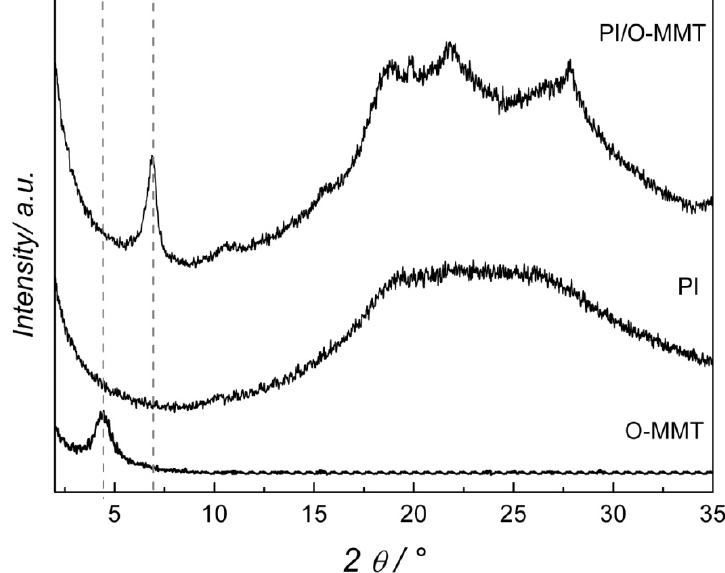
Figure 3. X-ray diffraction patterns of pure O-MMT, pure PI and